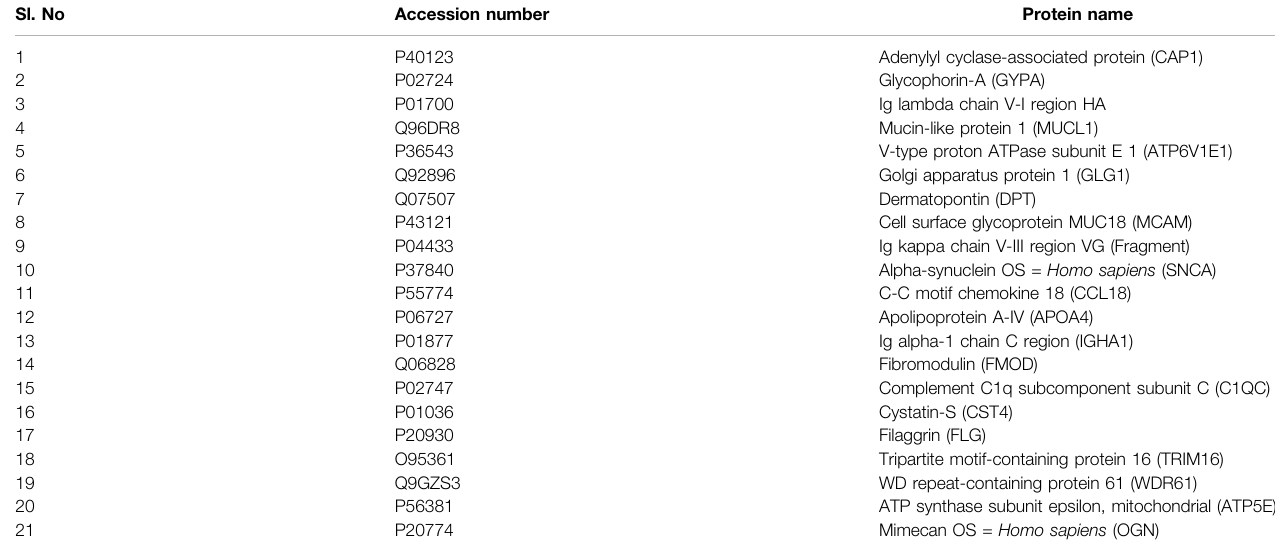
TABLE 2 | Common proteins in pseudoexfoliation (PXF) syndrome and pseudoexfoliation glaucoma (PXG). Sl.